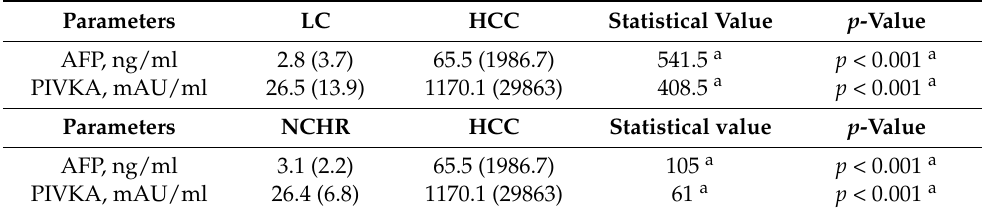
Table 3. Correlation of serum AFP and PIVKA with blood parameters, Child–Pugh score, and tumour staging.